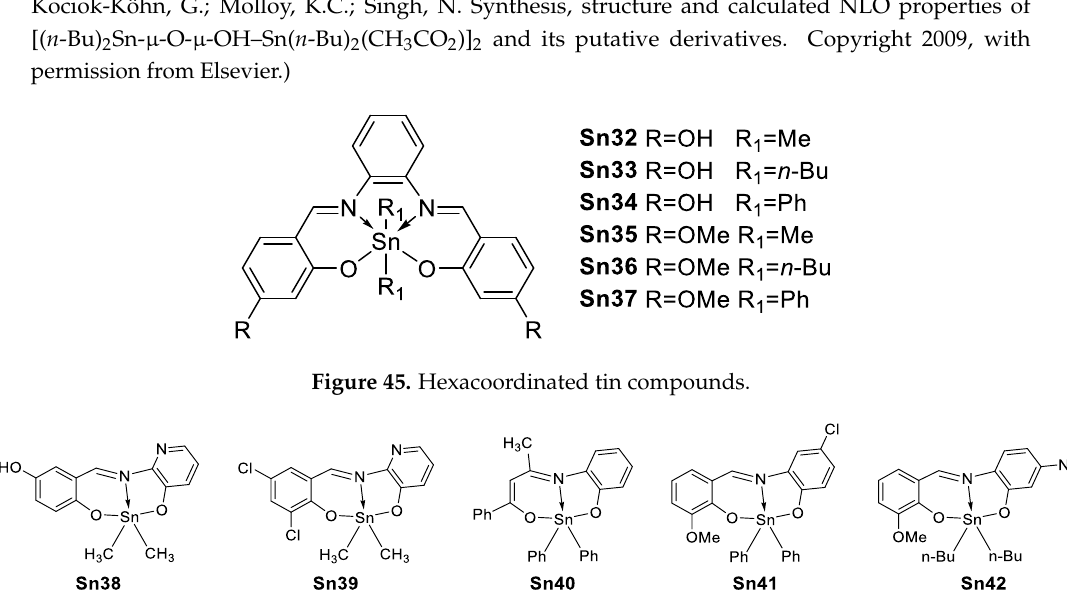
with potential second-order NLO response.